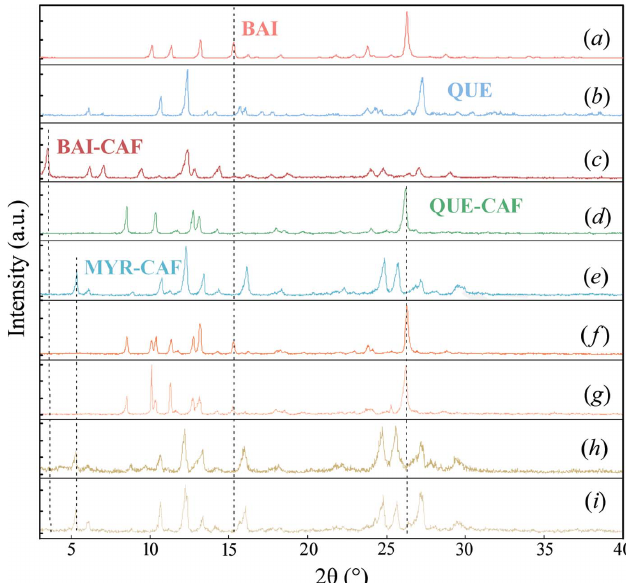
Figure 3 PXRD diffractograms of crystals ( a ) BAI and ( b ) QUE; slurry products of the three cocrystals ( c ) BAI–CAF, ( d ) QUE–CAF, ( e ) MYR–CAF; and competitive systems ( f ) BQC, ( h ) QMC; and physical mixtures of crystal and cocrystal ( g ) BAI:QUE–CAF 1:1, ( i ) QUE:MYR–CAF 1:1.